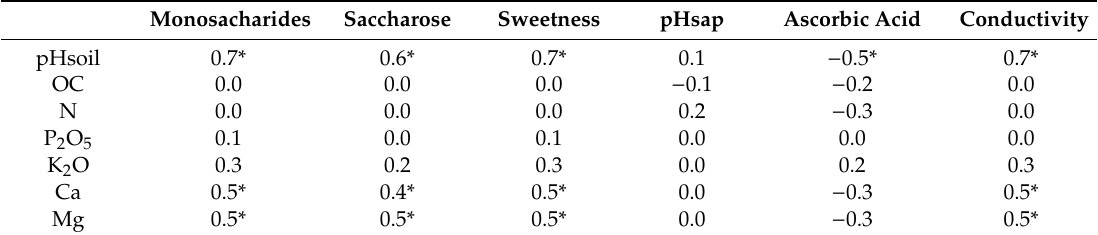
Table 3. Correlation matrix (based on Pearson correlation coe ffi cients) between the pH values as well as nutrient concentrations (in the 0–40 cm soil layer) of studied soils and the pH values, electrical conductivity and biochemical compounds of silver birch ( Betula pendula ) sap